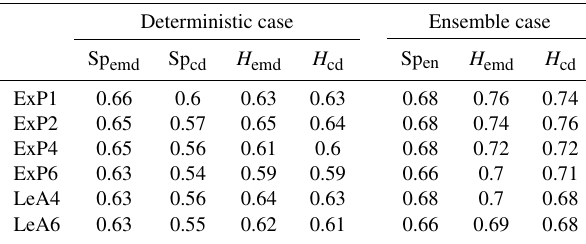
Table 4. As Table 3, but without the bias-correction